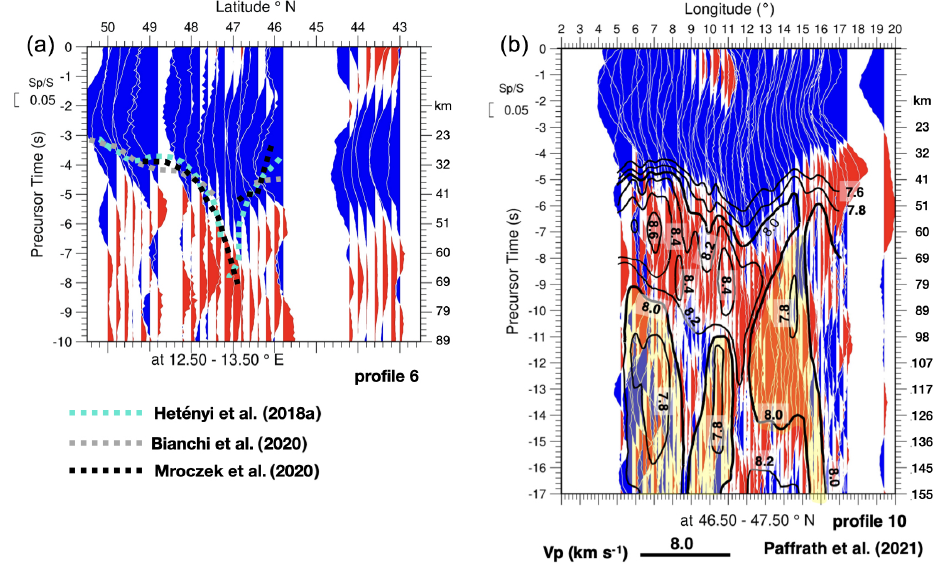
Figure 17. Copies of profiles 6 and 10, superposed with results of earlier studies for comparison. (a) Comparison of profile 6, focusing on Moho depth, with profiles of Hetényi et al. (2018b) based on P-receiver functions; Bianchi et al. (2021) based on PKP (core phases) crustal multiples; and Mroczek et al. (2020), also based on P-receiver functions. We did not mark Moho onsets in this figure as in Fig. 8a to allow comparison with the original data without our interpretation. (b) Comparison of profile 10, focusing on the depth of the base of the NVG indicated by a grey shadow in Fig. 12b, with absolute P-wave velocities obtained from teleseismic P-wave travel time tomography by Paffrath et al. (2021).